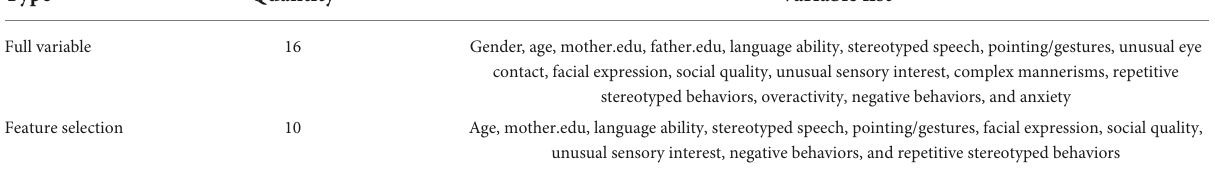
TABLE 3 Comparison of full variables and variables after feature